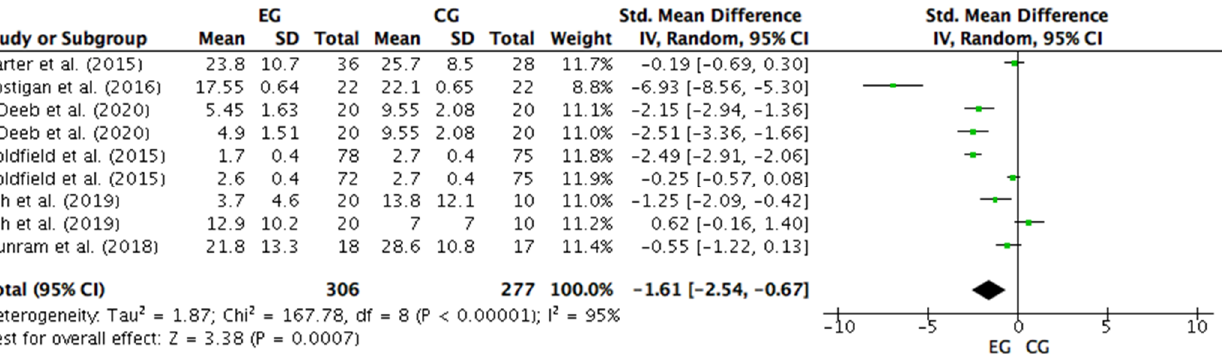
Figure 6. Forest Plot comparing the effects of training with different modes of strength intervention on depression levels. EG: experimental group; CG: control group; SD: standard deviations.